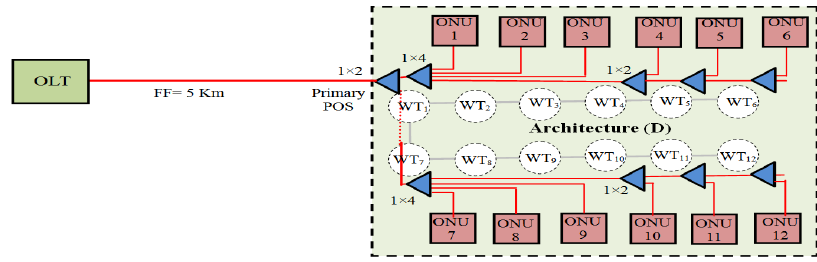
Figure 6. EPON ‐ based architecture (D).